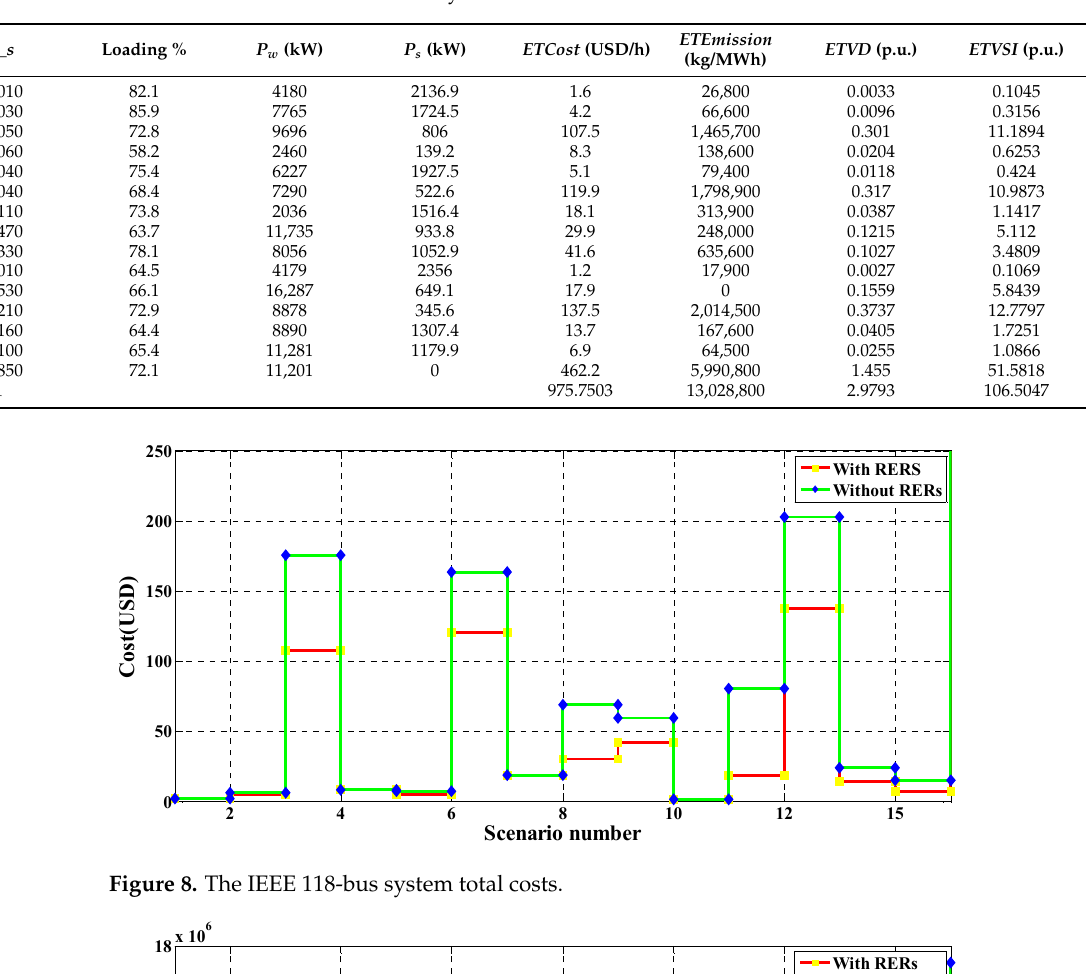
Table 6. The IEEE 118-bus system simulation results.